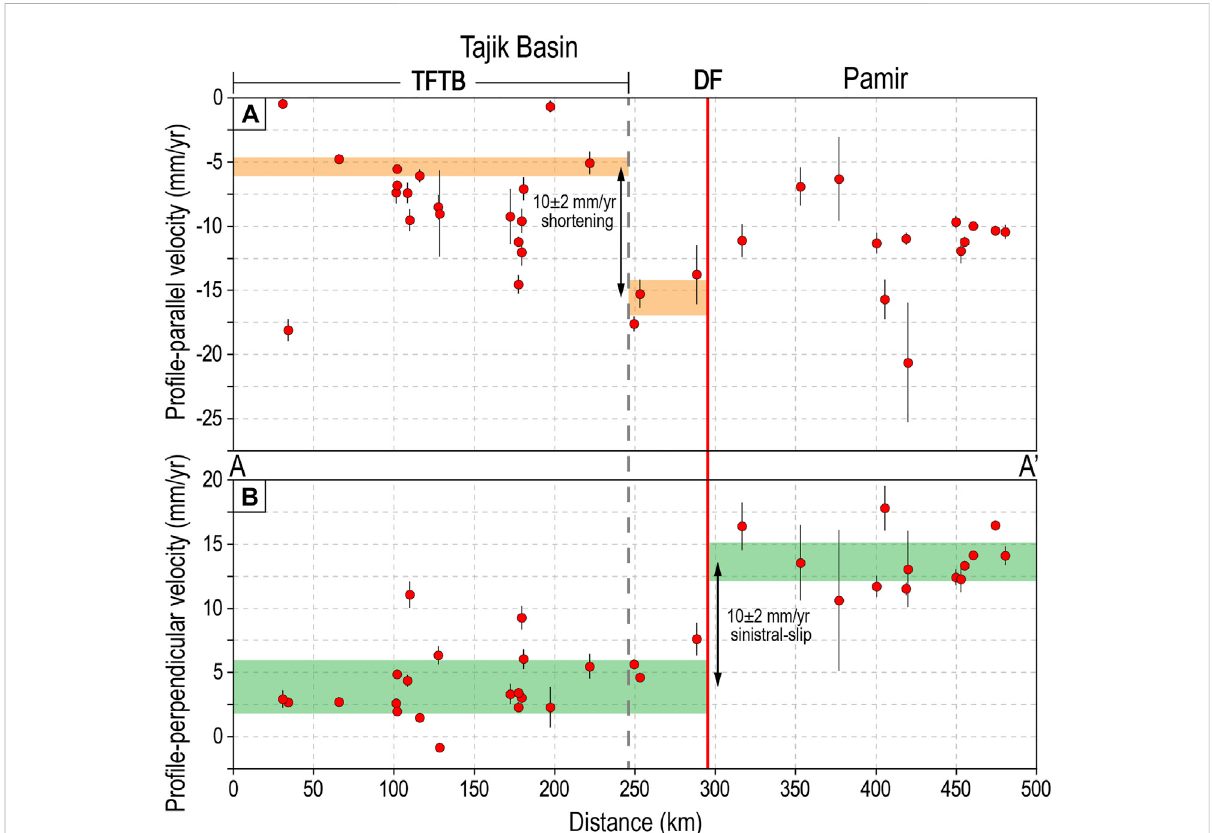
FIGURE 4 GPSvelocitypro fi leA – A ’ (seelocationinFigure3). (A) Velocitiesparalleltothepro fi le. (B) Velocitiesperpendiculartothepro fi le.Coloredstripes show velocity ranges. The dark grey dashed line and bold red line mark the tectonic domain boundary and fault location, respectively. Fault names same as Figure